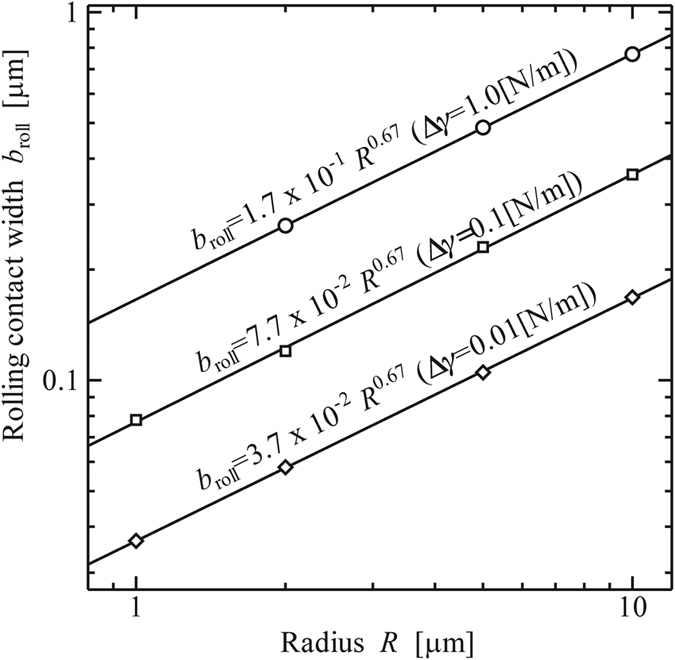
Width of contact area at the beginning of rolling, broll [μm].(Material: polystyrene, E = 3.8 [GPa], ν = 0.34).